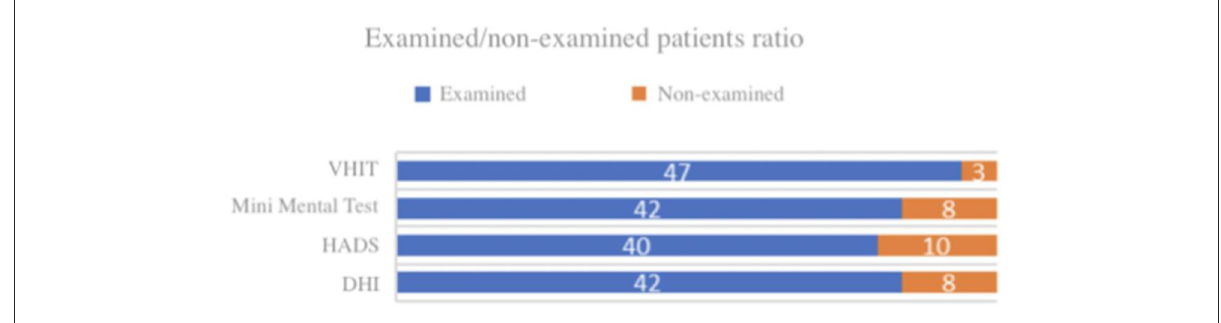
FIGURE3 Subjects examined/not evaluated by vHIT, MMT, HADS, and